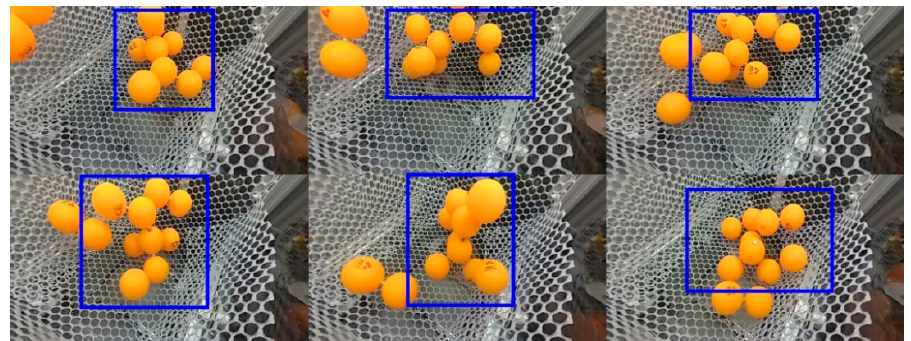
Figure 6. The breaking process of an unstable connected structure (which is highlighted by the blue wireframe).